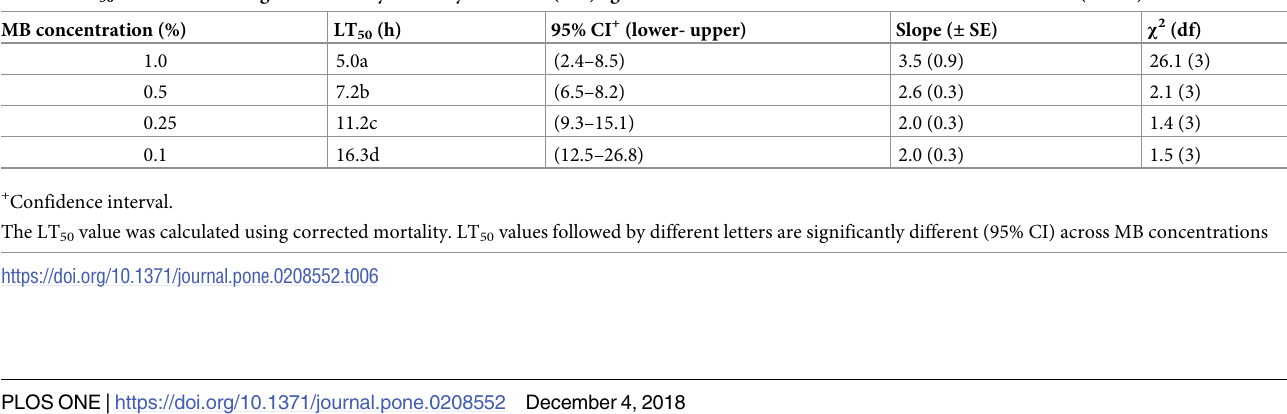
Data are presented as means ± SE (n = 3). Means followed by same letters within a column are not significantly different, based on one-way ANOVA and Tukey’s HSD post-hoc test ( P < 0.05).